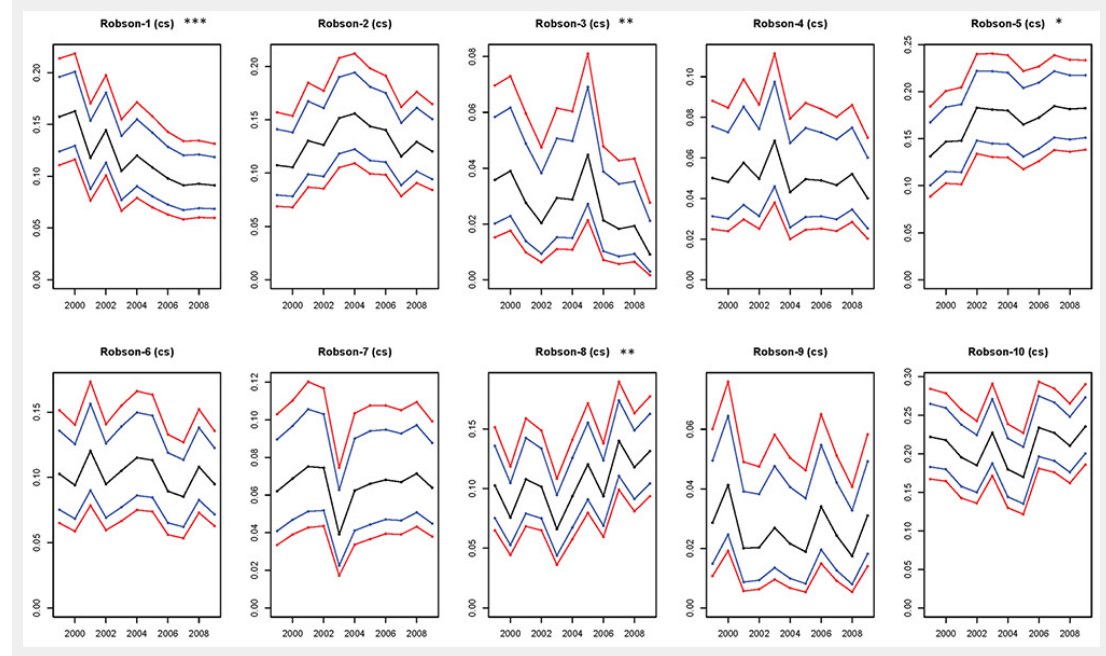
Figure 3 Temporal change within each Robson group in births delivered by caesarean section. Relative size is presented in the observation period of time. Blue lines are 95% confidence limits and red lines are simultaneous 95% confidence limits. The relative size of Groups 1 and 3 decreased significantly and the relative size of Groups 5 and 8 was significantly increased. *p ≤0.05; **p ≤0.01; ***p ≤0.001